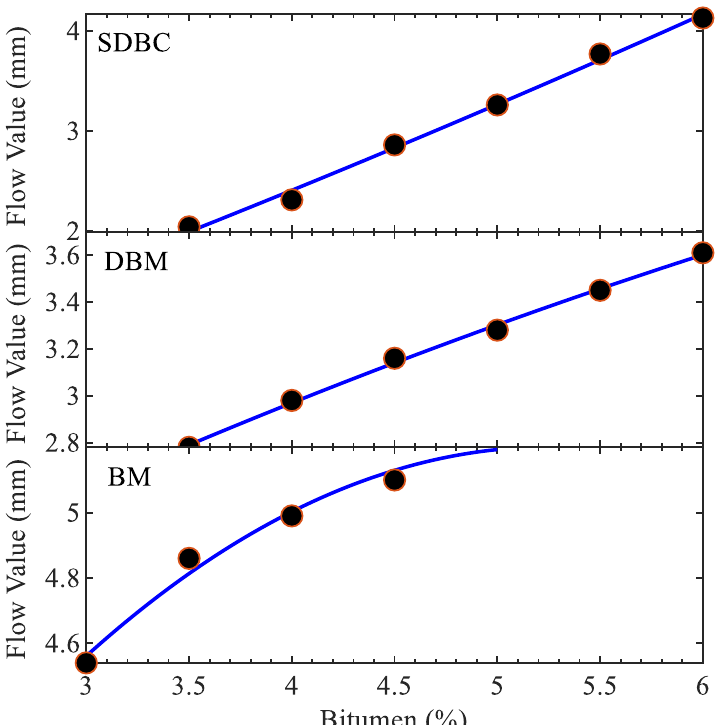
Fig. 7 Relations between flow value with bitumen content for SDBC, DBM, and BM